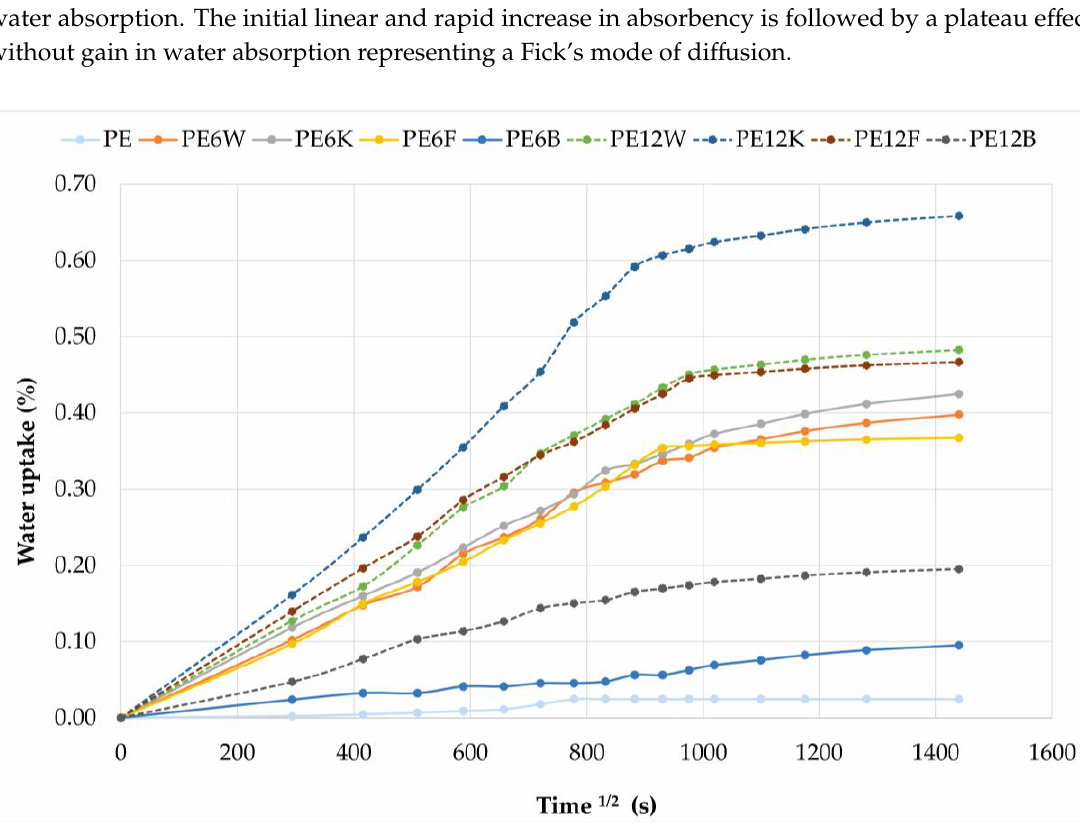
Figure 10. Water absorption curves of different composites as function of square root of immersion time in seconds.